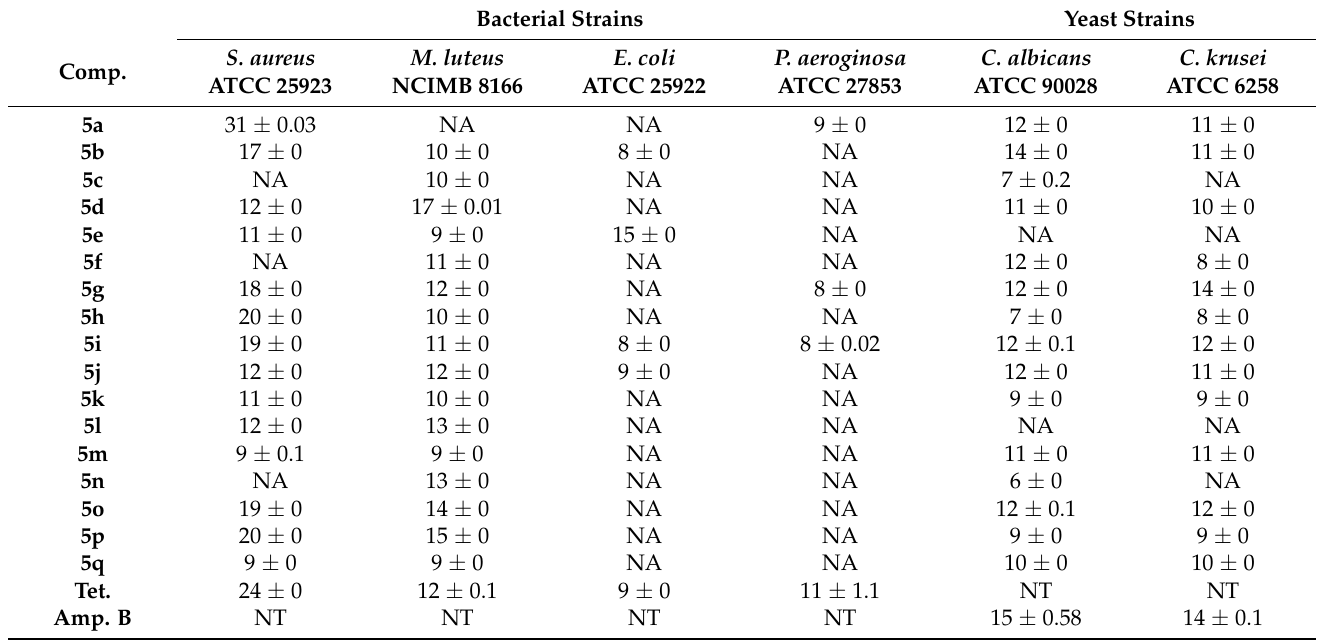
Table 5. Antibacterial and antifungal activity of series 5 (Inhibition zone in mm). Bacterial Strains Yeast Strains